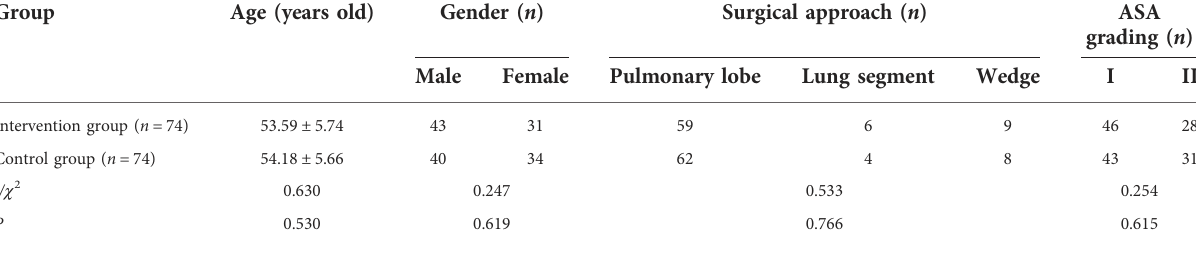
TABLE 1 Comparison of two groups of general data.